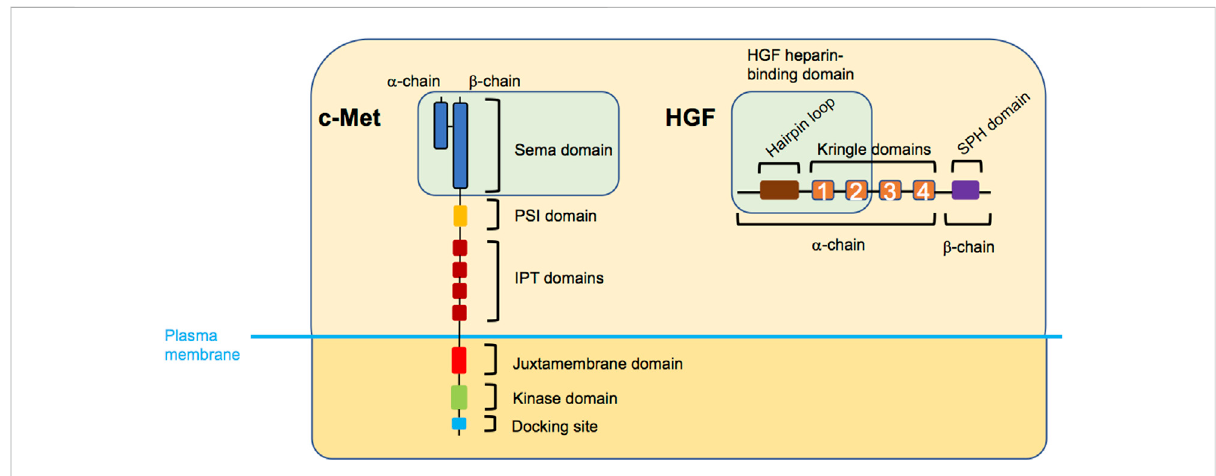
FIGURE 1 Structure of c-Met and HGF. The extracellular region of c-Met entails the Sema domain, plexin-semaphorin-integrin (PSI) domain, and four consecutively arranged immunoglobulin-plexin-transcription (IPT) factors domains, while the intracellular part is composed of a juxtamembrane domain, a kinase domain, and the docking site domain. HGF entails the hairpin loop, four consecutive kringle domains, and a serine protease homology (SPH) domain. The green boxes indicate the c-Met-HGF binding regions. Note, that the PSI and IPT domains are also involved in correct positioning of